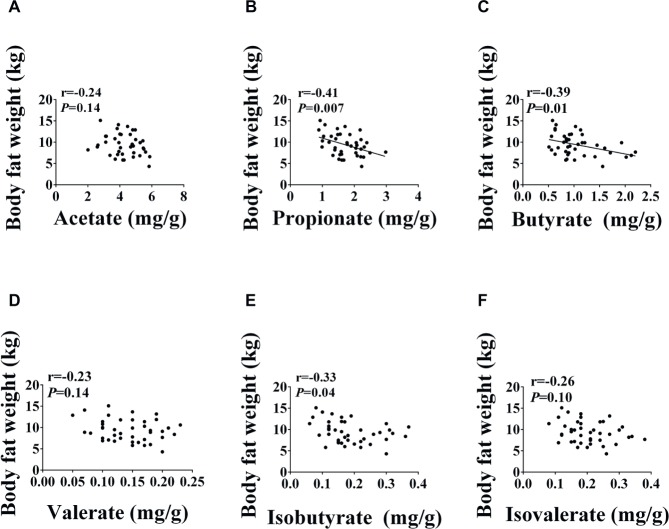
Relationship between SCFAs and body fat weight. Pearson correlations were used to determine the association between body fat weight and colonic acetate (A), propionate (B), butyrate (C), valerate (D), isobutyrate (E), and isobutyrate (F) concentrations.